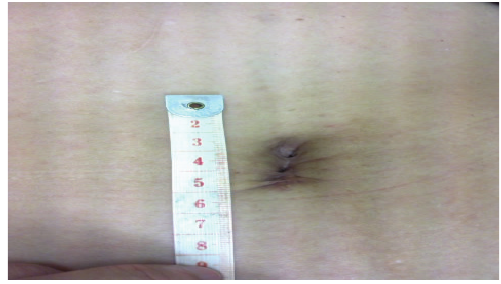
Figure 4: “Scarless” incision site (1 year